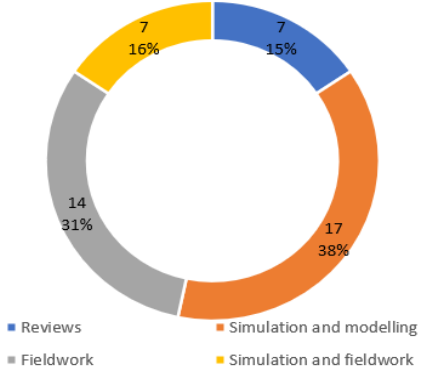
Figure 7. Methods applied by the studies.